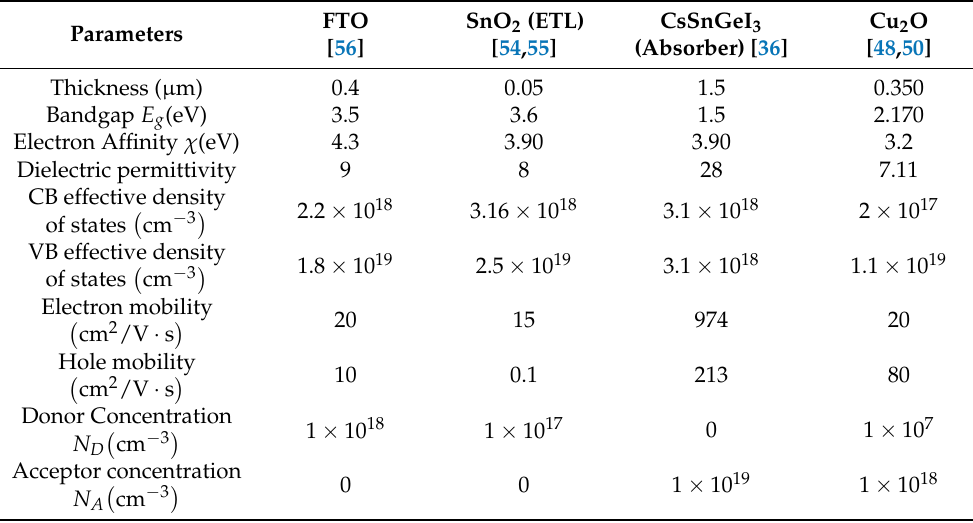
Table 1. Electrical and optical properties used in simulation of CsSnGeI 3 -based perovskite solar cell.